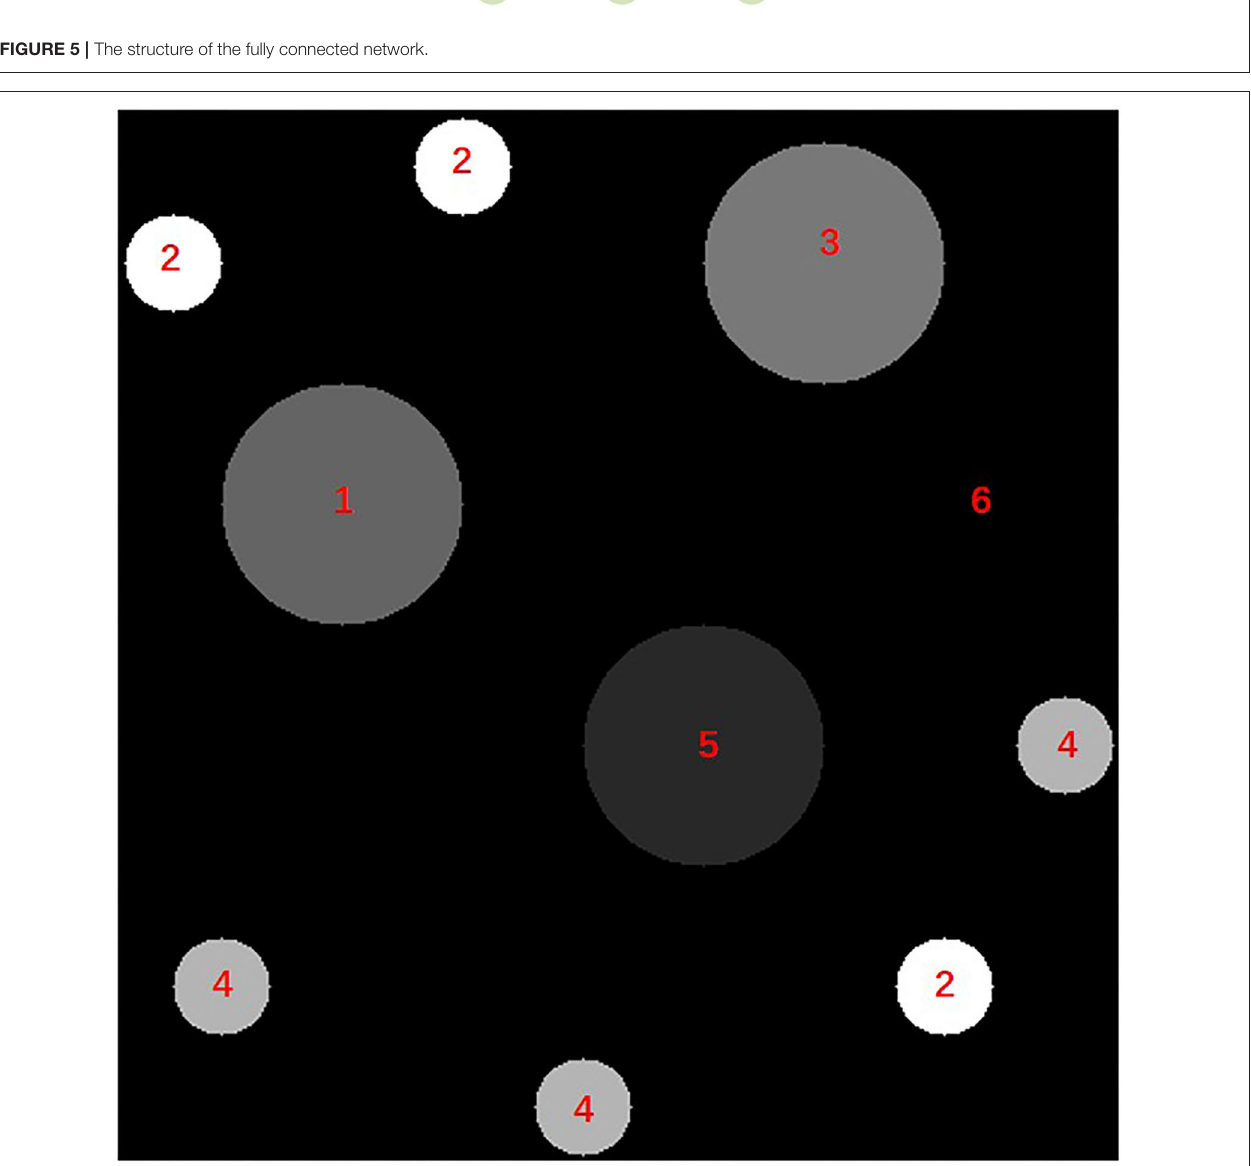
FIGURE 6 | The diagram of the pre-calibrated phantom. The materials represented by numbers 1– 6 are: adipose tissue, bone, muscle, blood and iodine, lung tissue, air.